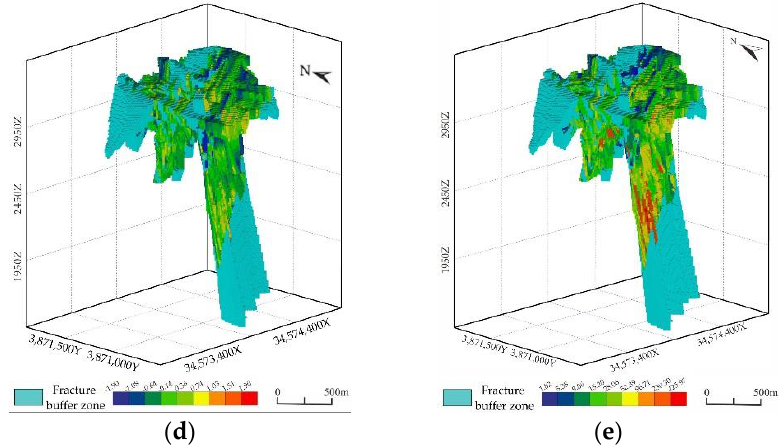
Figure 6. ( a ) Fracture buffer zone; ( b ) Element association of fracture; ( c ) Au anomaly; ( d ) Element association of near-ore halo; ( e ) Geochemical parameter (Front halo/tail halo). Table 1. Geological and geochemical quantitative mineral resource prediction model at depth of the Zaozigou gold deposit.